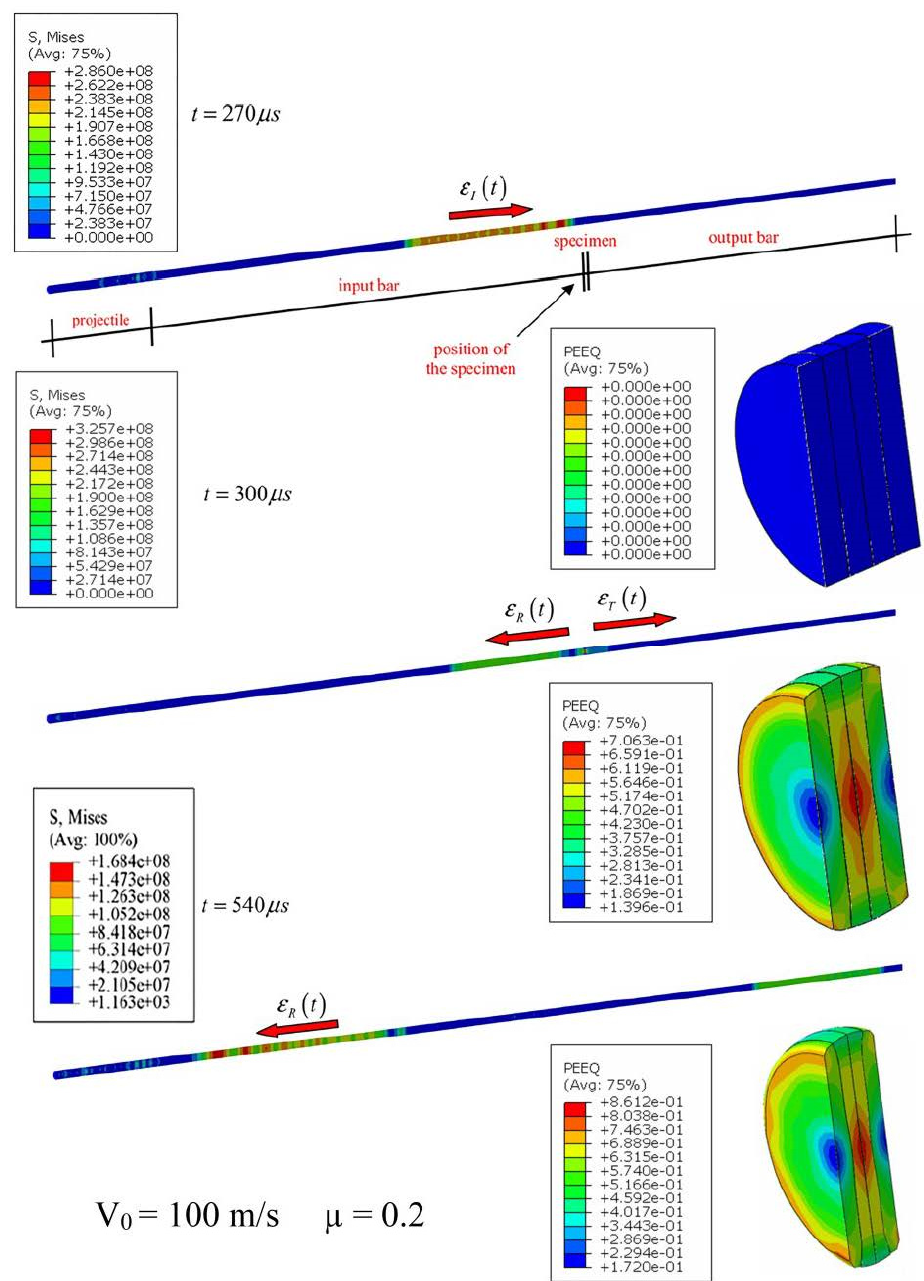
Figure 10. Numerical simulation of the wave’s propagation along SHPB with the AW 5005 aluminum alloy as received specimen.